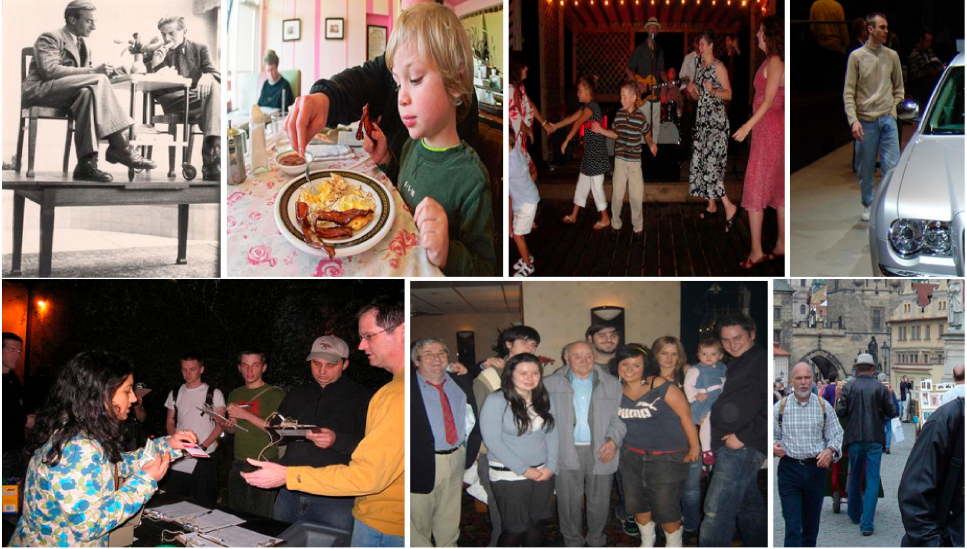
Figure 4. Oxford hand dataset sample